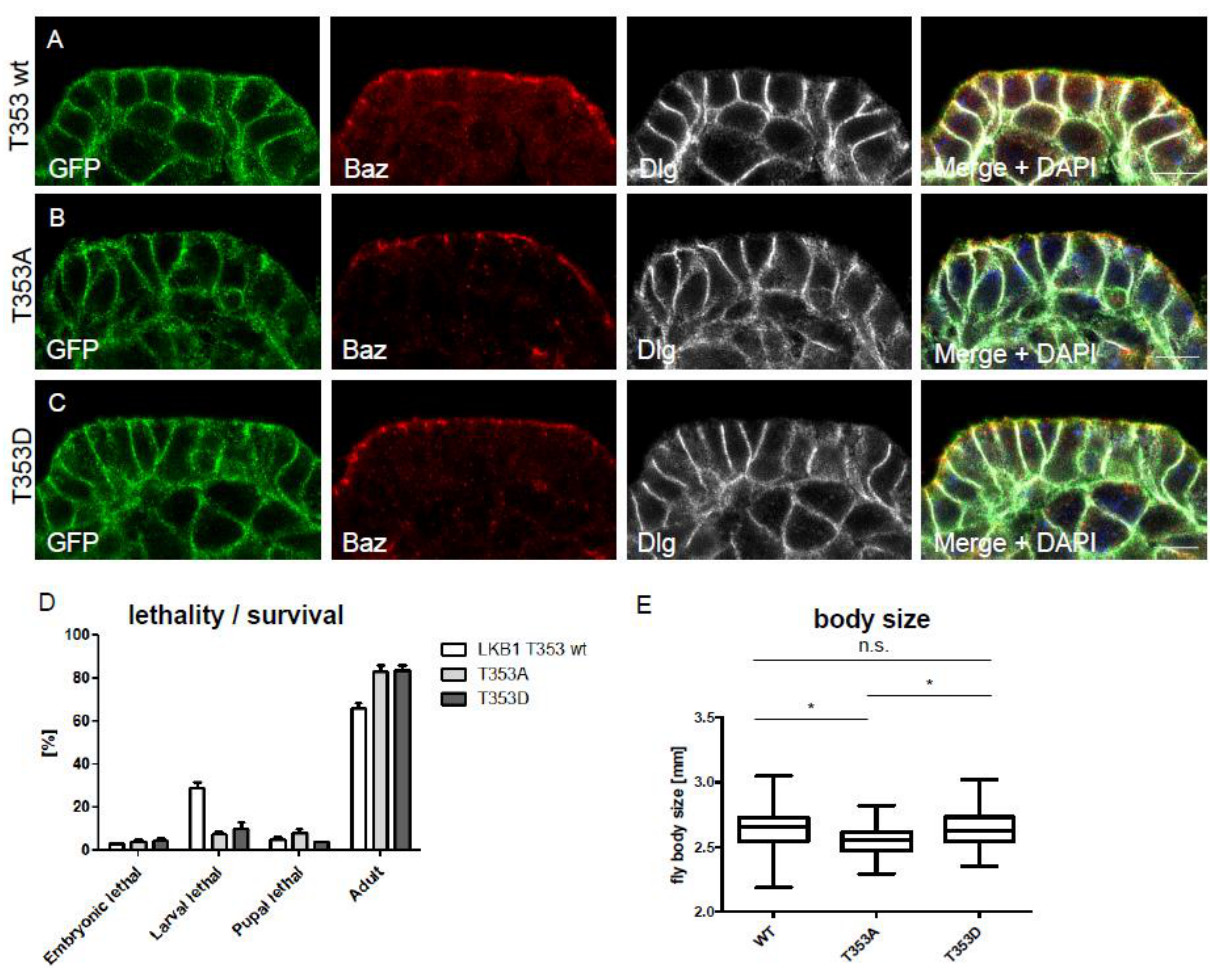
Figure 2. GFP-LKB1 variants localize normally and do not impair fly survival but affect body size ( A – C ) Immunostainings of embryonic epidermis epithelial cells expressing GFP-LKB1 variants from its endogenous promoter. Discs large (Dlg) was used as marker for the lateral membrane and Bazooka (Baz) marks the apical junctions. ( D ) Flies with CRISPR/Cas9-mediated knockin of wild type LKB1, LKB1 T353A or LKB1 T353D display comparable survival rates ( n = 100, N = 3), but different body sizes ( E ), n ≥ 35. Scales bars are 5 µm in ( A – C ). Error bars are standard error of the means. Significance was determined by one way ANOVA with Bonferroni multiple comparison test: * p < 0.05, n.s. not significant.